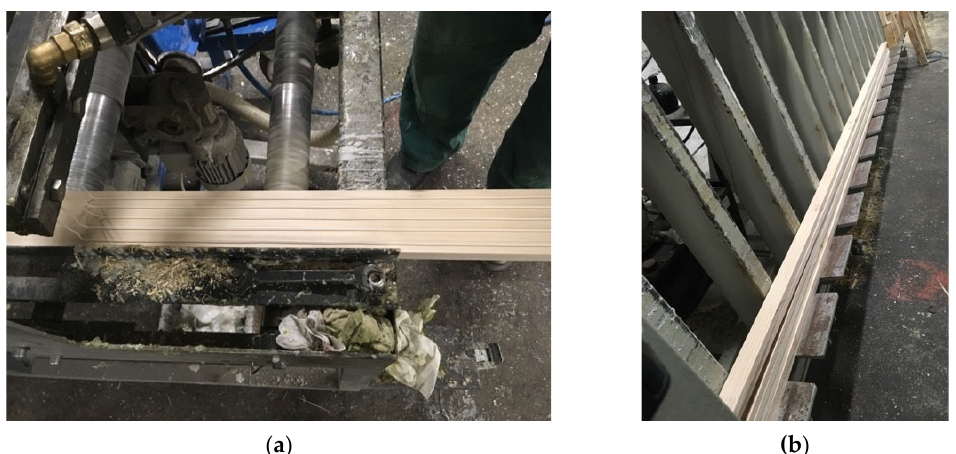
Figure 2. Production of GLT: ( a ) adhesive application and ( b ) beam arrangement in the press (authors’ archive).